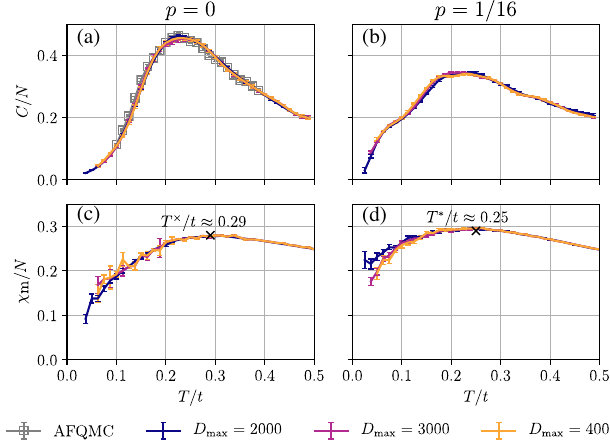
FIG. 6. Specific heat C and magnetic susceptibility χ m at U=t ¼ 10 of a 32 × 4 square cylinder for hole dopings p ¼ 0 (left) and p ¼ 1 = 16 (right). We compare results with METTS using 2000 , 3000, different maximal bond dimensions D max ¼